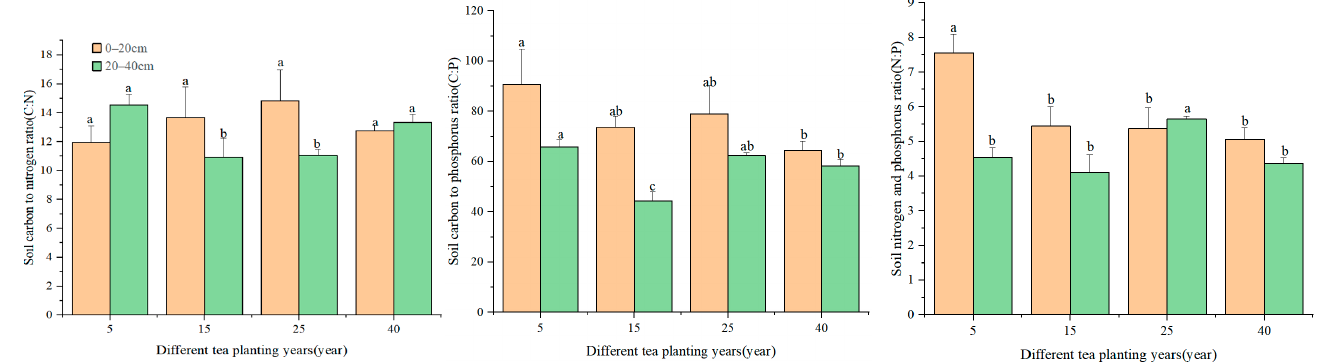
Figure 2. Stoichiometric ratio of soil nutrients in tea gardens under different planting years. Different lowercase letters under the same soil layer represent that the data in different planting years are significantly different ( p < 0.05).